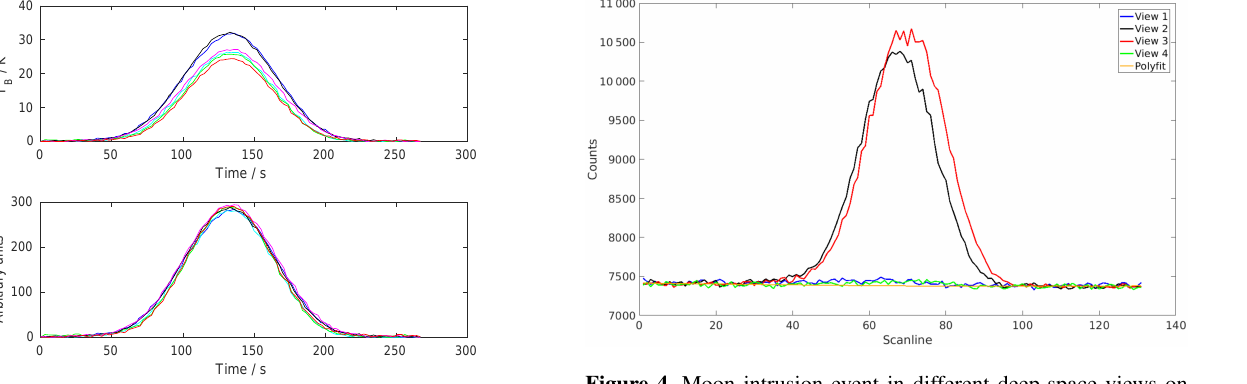
Figure 3. Moon intrusion events observed with channel H1 of MHS (magenta: NOAA18, 9 January 2006; red: NOAA18, 8 April 2006; green: NOAA18, 19 November 2007; cyan: NOAA18, 1 April 2015; blue: NOAA18, 22 January 2016; black: NOAA19, 22 December 2015). Top: counts divided by gain. Bot- tom: counts divided by gain and scaled with the inverse of the solid angle and brightness temperature of the Moon. The counts corre- sponding to the CMB level were subtracted.